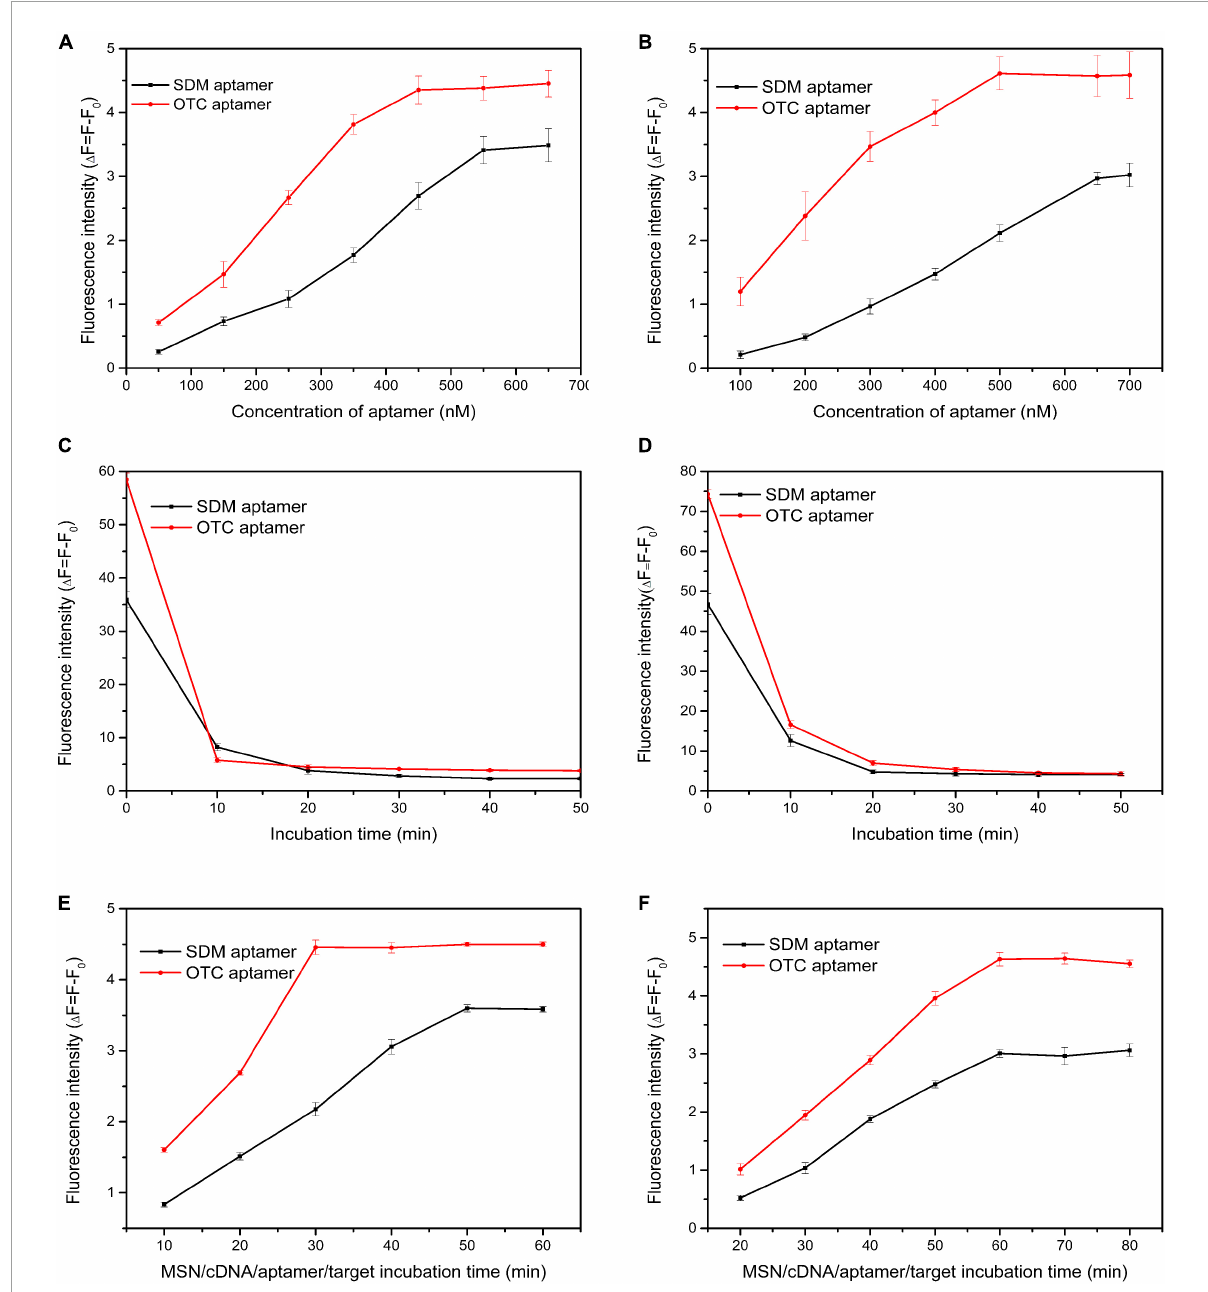
FIGURE4 (A,B) Optimization of aptamer concentration; (C,D) optimization of incubation time of aptamer/cDNA; (E,F) optimization of incubation time for aptamer/target. The concentrations of sulfadimethoxine (SDM) and oxytetracycline (OTC) were set at 100 ng/mL. (Panels A,C,E : SDM and OTC aptamers were added separately; panels B,D,F : SDM and OTC aptamers were added simultaneously).